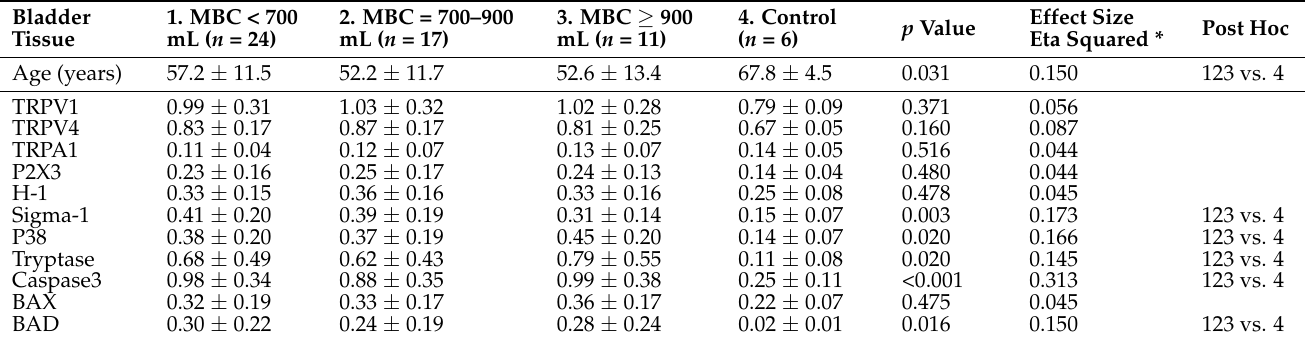
Table 5. Sensory, inflammatory, and pro-apoptotic protein expression levels in the urothelium of patients with interstitial cystitis/bladder pain syndrome with maximal bladder capacity and controls.